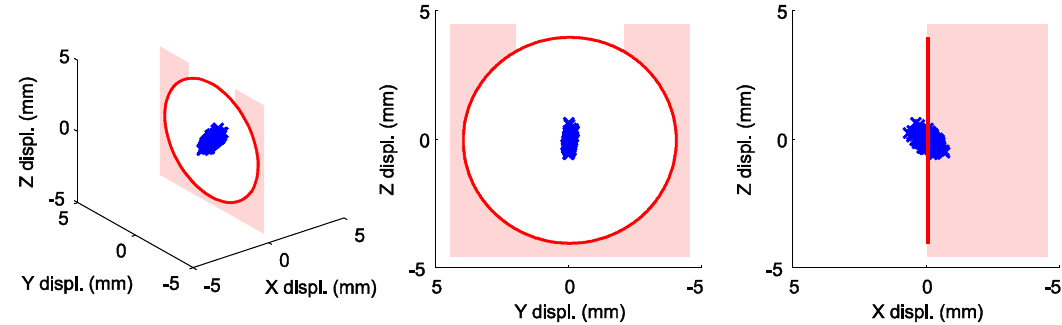
Figure 11. The calculated positions of ε are marked with blue crosses, while the correct UU WEC stator section slot position is shown in red. The figure is based on 400 measurements.